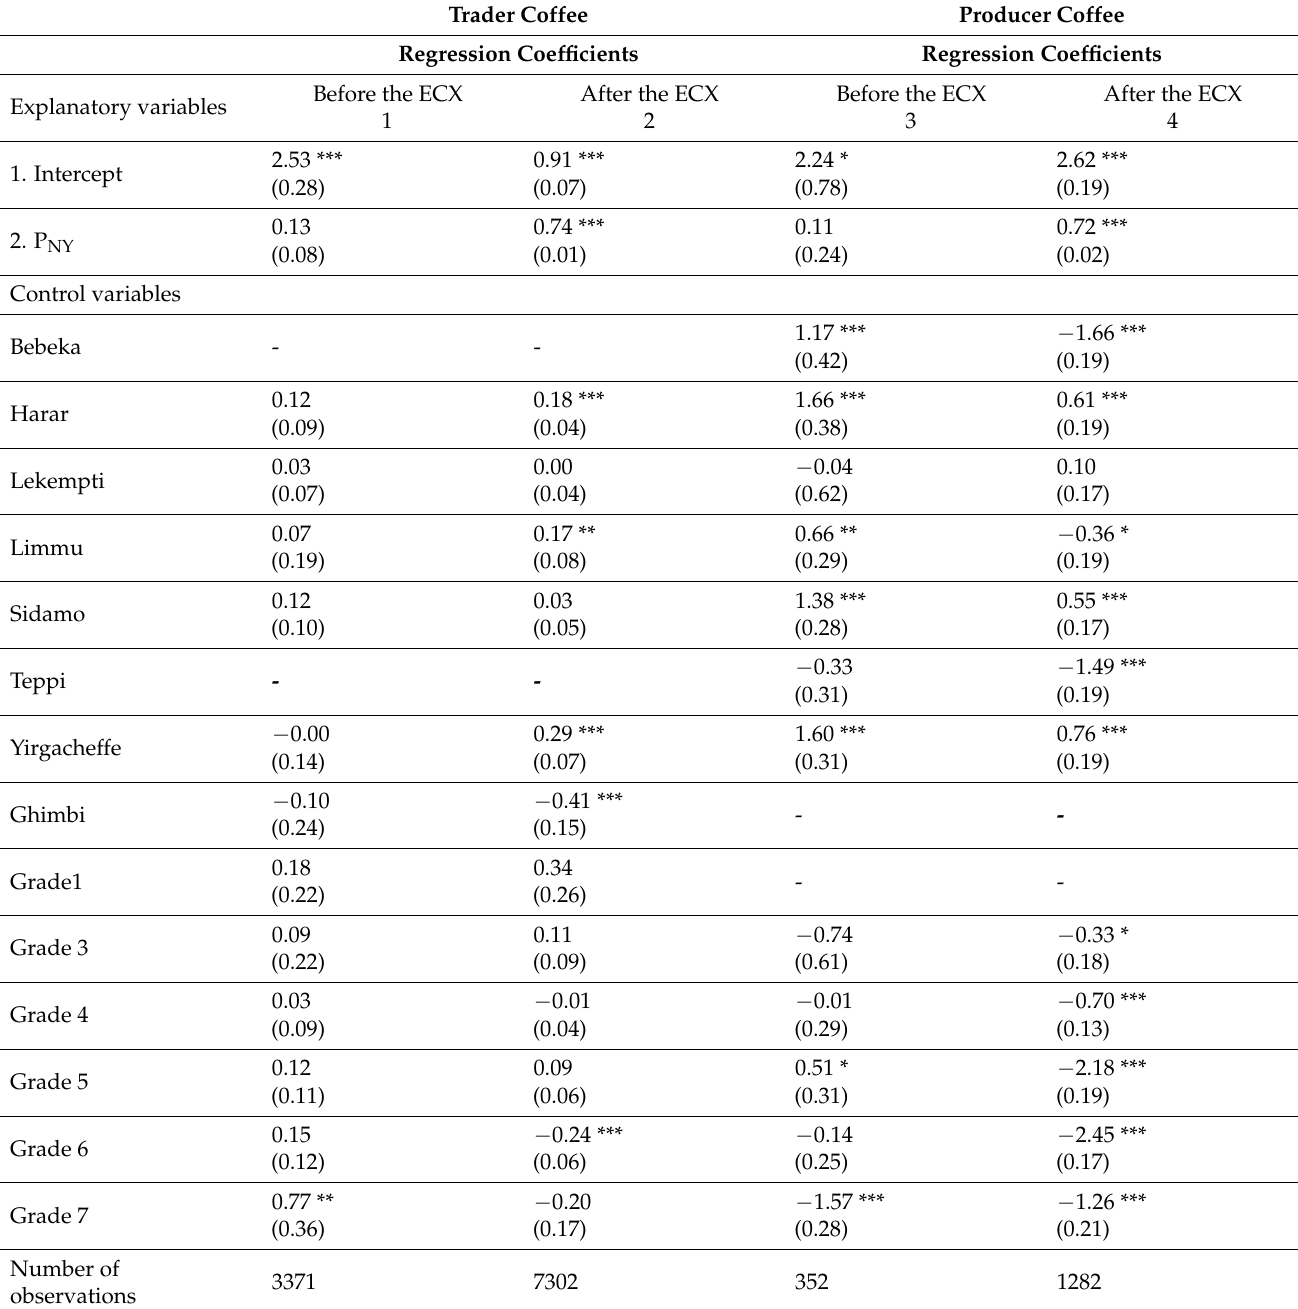
Table 4. Comparison between ordinary least squares regressions before and after coffee began to be traded at the ECX. Trader Coffee Producer Coffee Regression Coefficients Regression